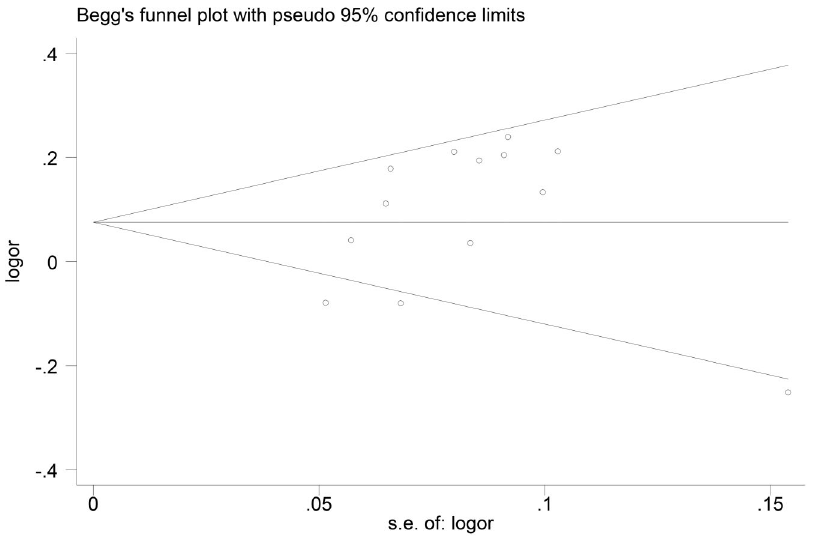
Figure 4. Begg’s funnel plot for publication bias (additive model). Each point represents a separate study for the indicated association. Log[or], natural logarithm of the odds ratio. Horizontal line, mean effect size.